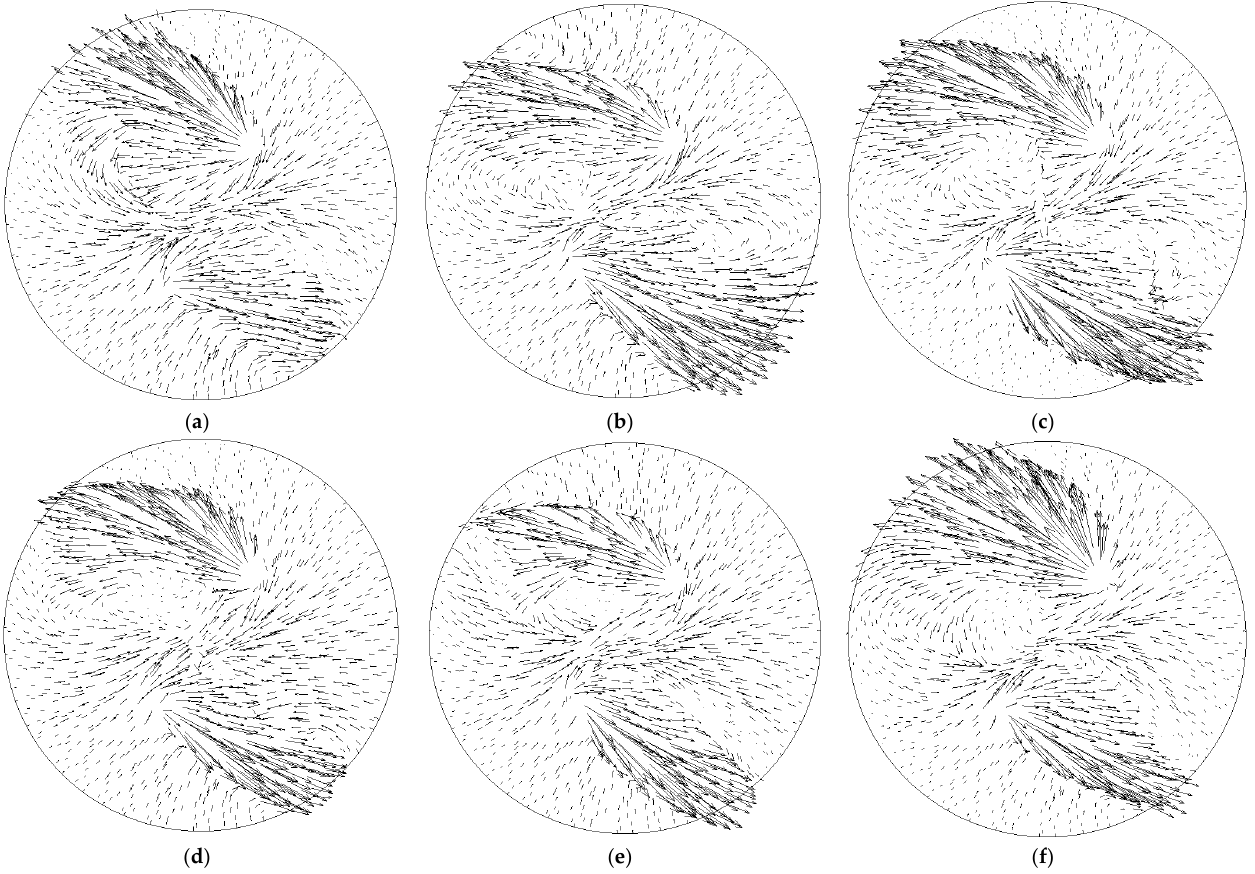
Figure 23. When inlet pressure = 15 MPa, gap = 1.5 mm, the variation of velocity vector of Suction cup- θ 20 with time in adhesion interface plane at: ( a ) 5 ms, ( b ) 9.4 ms, ( c ) 13.8 ms, ( d ) 18.2 ms, ( e ) 22.6 ms, ( f ) 27 ms.